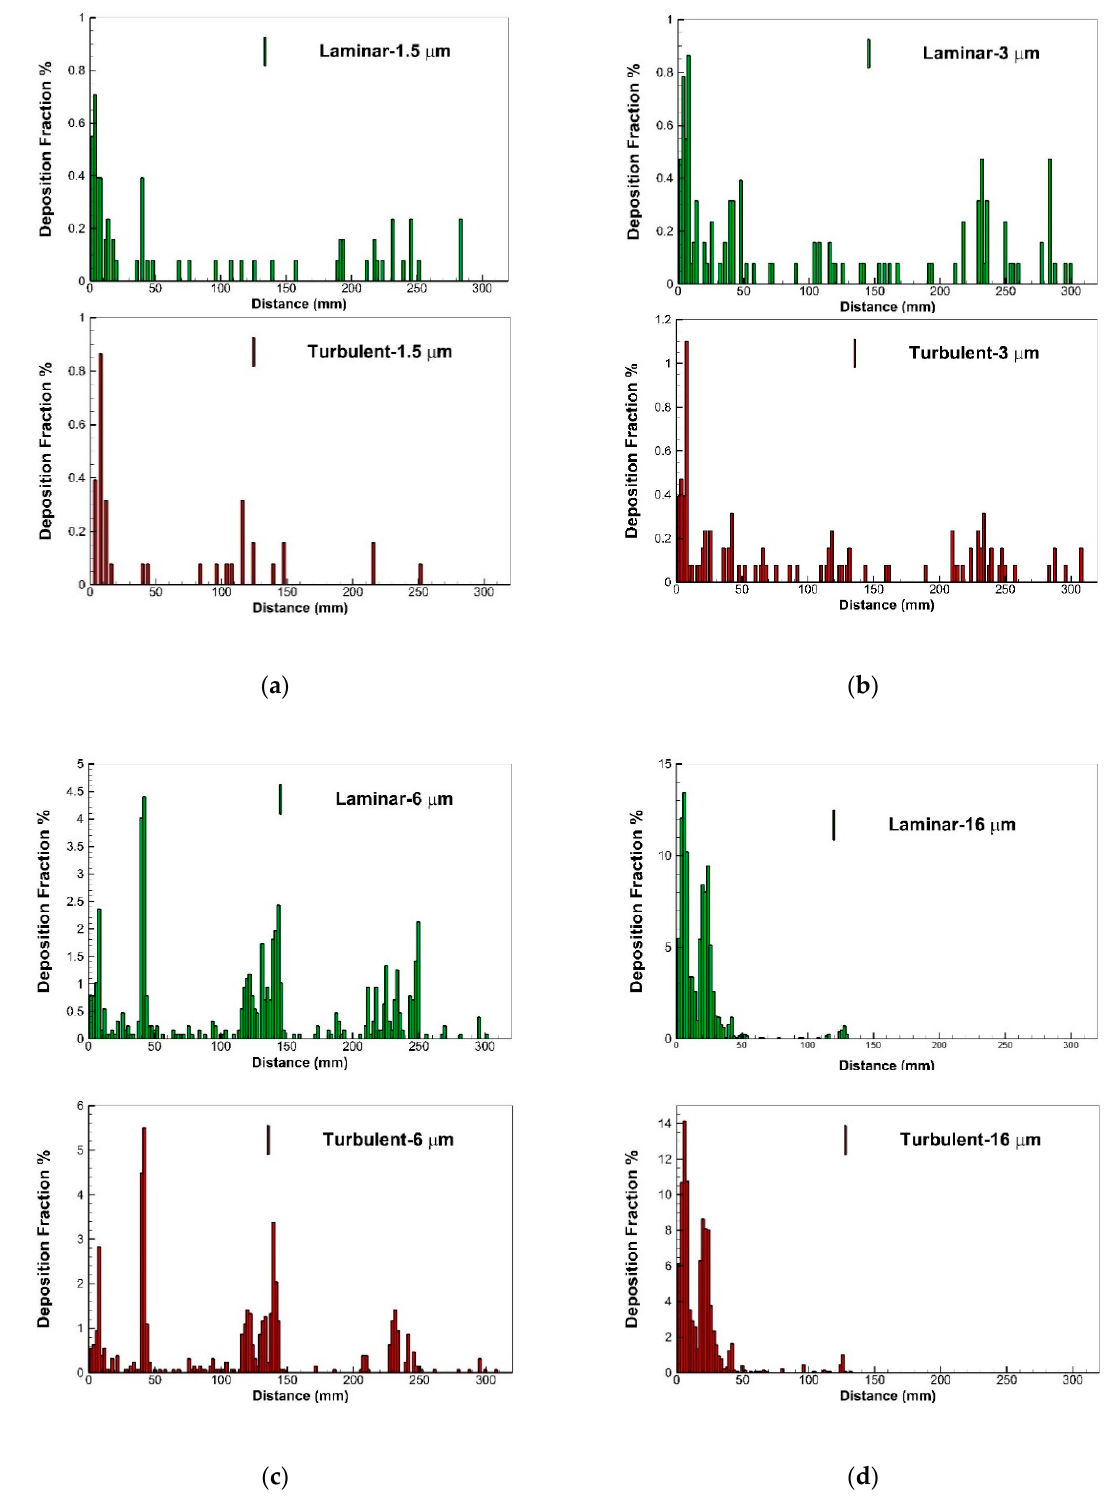
Figure 13. A comparison between deposition fractions (%) for different sizes of particles along the geometry (inlet air flow rate of 10 L/min). Laminar and turbulent models are shown for particle diameters of 1.5 μ m ( a ), 3 μ m ( b ), 6 μ m ( c ) and 16 μ m ( d ). In consideration of drug delivery devices, the selection of optimal drug delivery con- ditions is largely contingent on the target site and region of interest. In general, high inlet